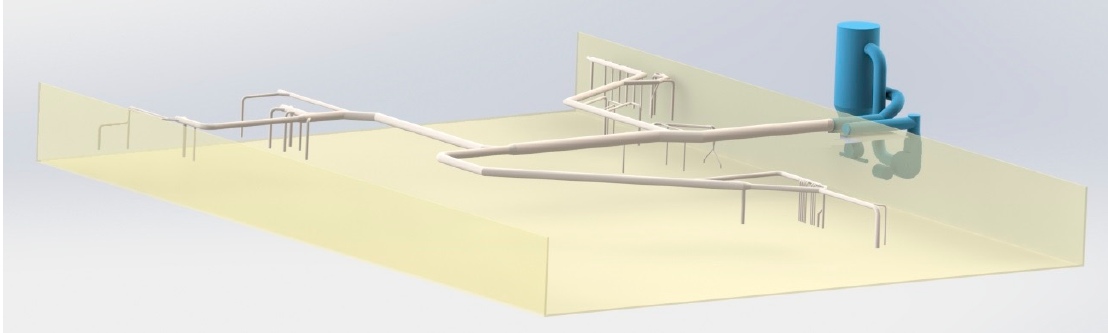
Figure 15. Dust collecting network.